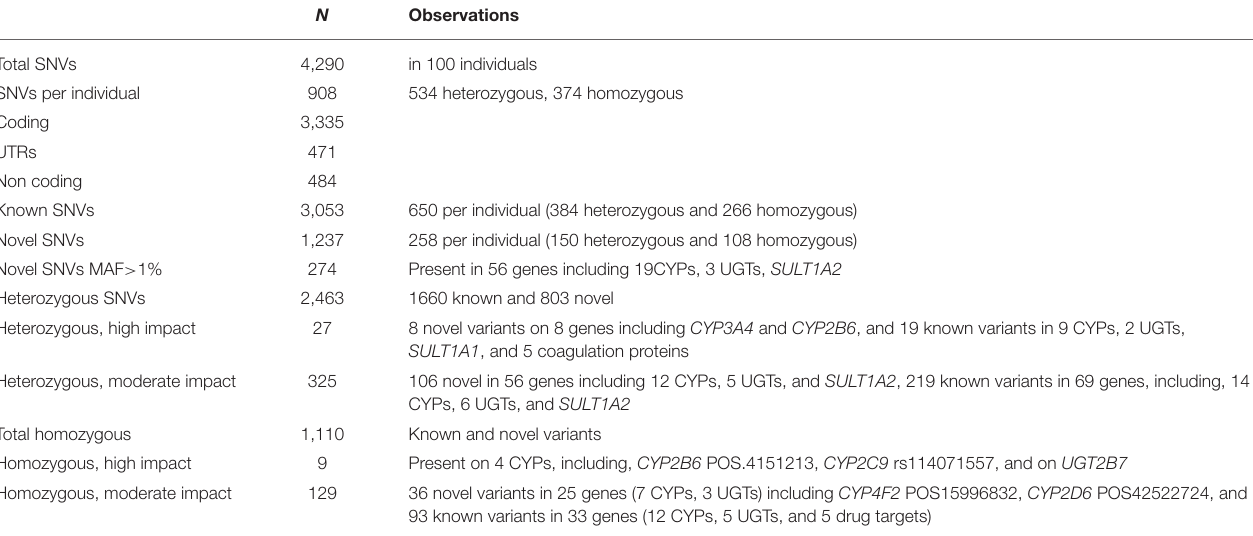
TABLE 2 | Summary of NGS genetic